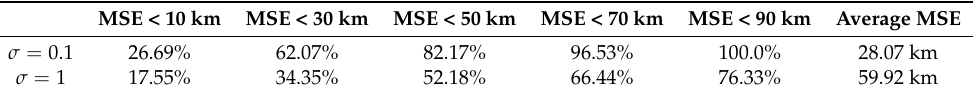
Table 1. Percentage of areas with different MSEs using the first set of six fixed receivers deployment under σ = 0.1 and σ = 1.